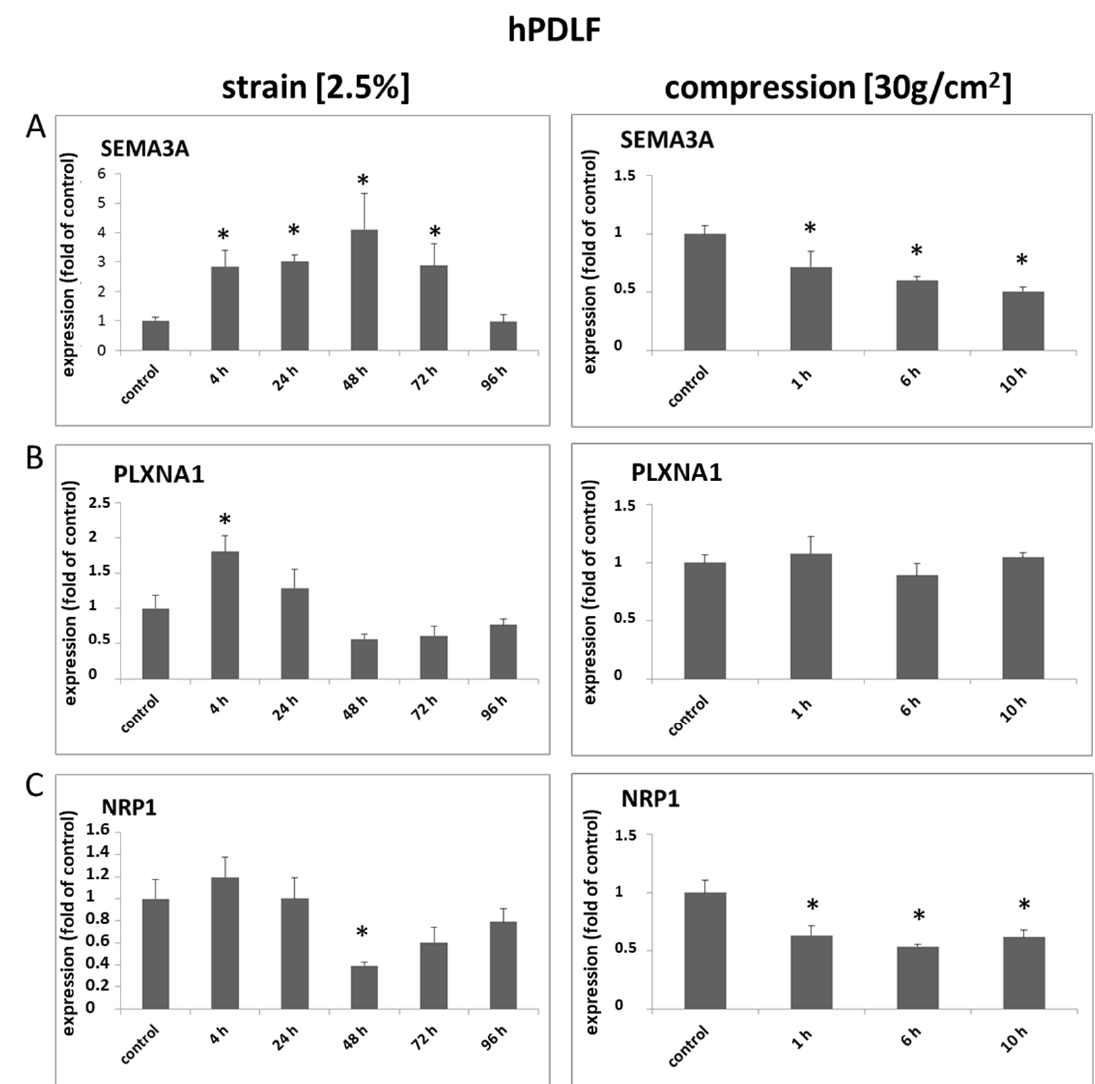
Figure 1. The mRNA expression of SEMA3A, PLXNA1 and NRP1 is differentially regulated from mechanical compression or strain. Three independent primary human PDLF (hPDLF) populations were either stretched (2.5%) or compressed (30 g/cm 2 ) for the indicated periods of time. Stretching and compression had opposite effects on the expressions of SEMA3A ( A ), PLXNA1 ( B ) and NRP1 ( C ). Experiments were carried out in triplicates. Untreated cells served as controls. Quantitative RT-PCR experiments were carried out in triplicates. Cumulative data of the three cell populations data are given as mean ± SD. * = p < 0.05 vs. control (Kruskal–Wallis one-way analysis of variance on ranks (ANOVA), followed by Dunn’s post-hoc test).